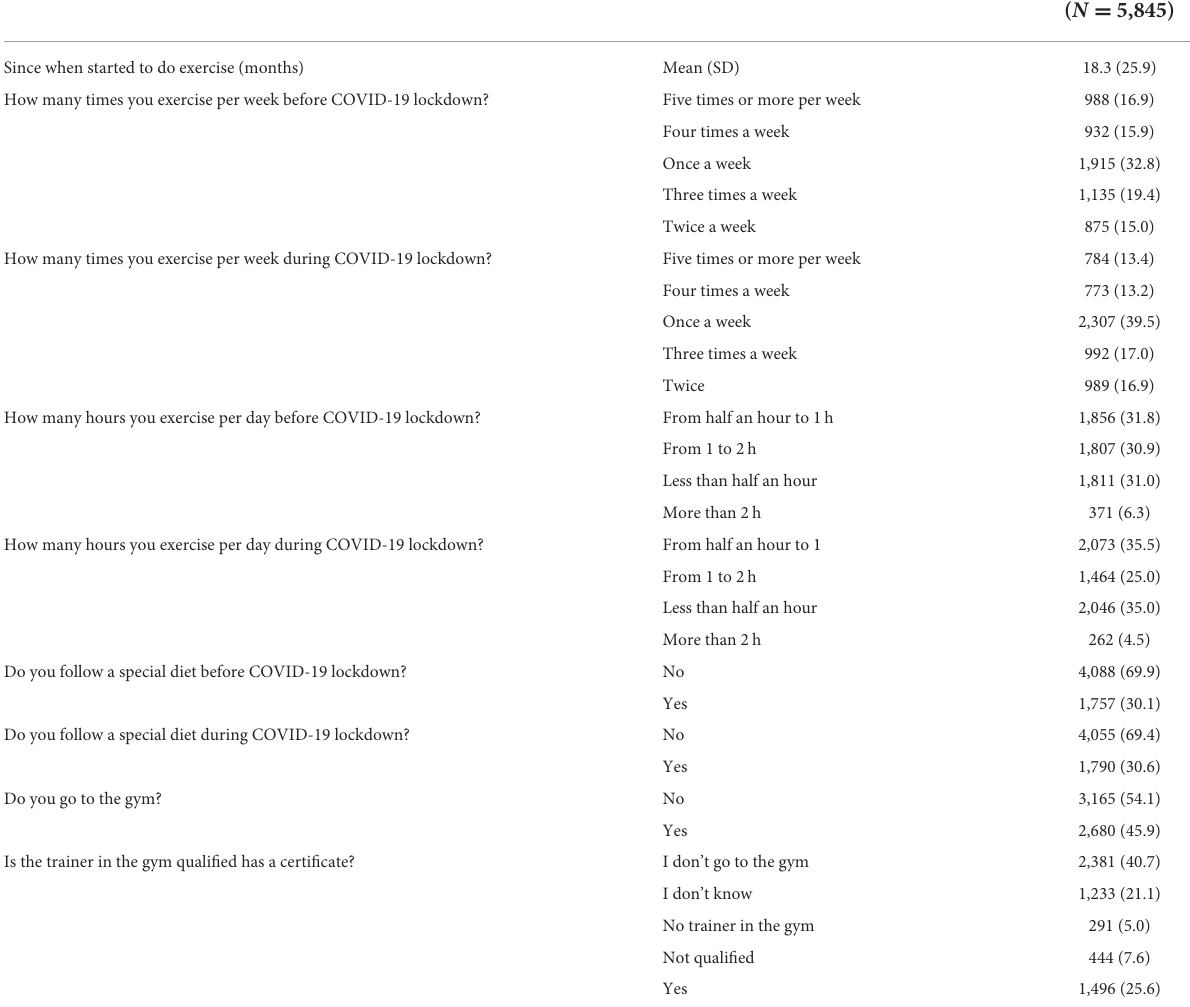
TABLE 2 Baseline training characteristics among study population.